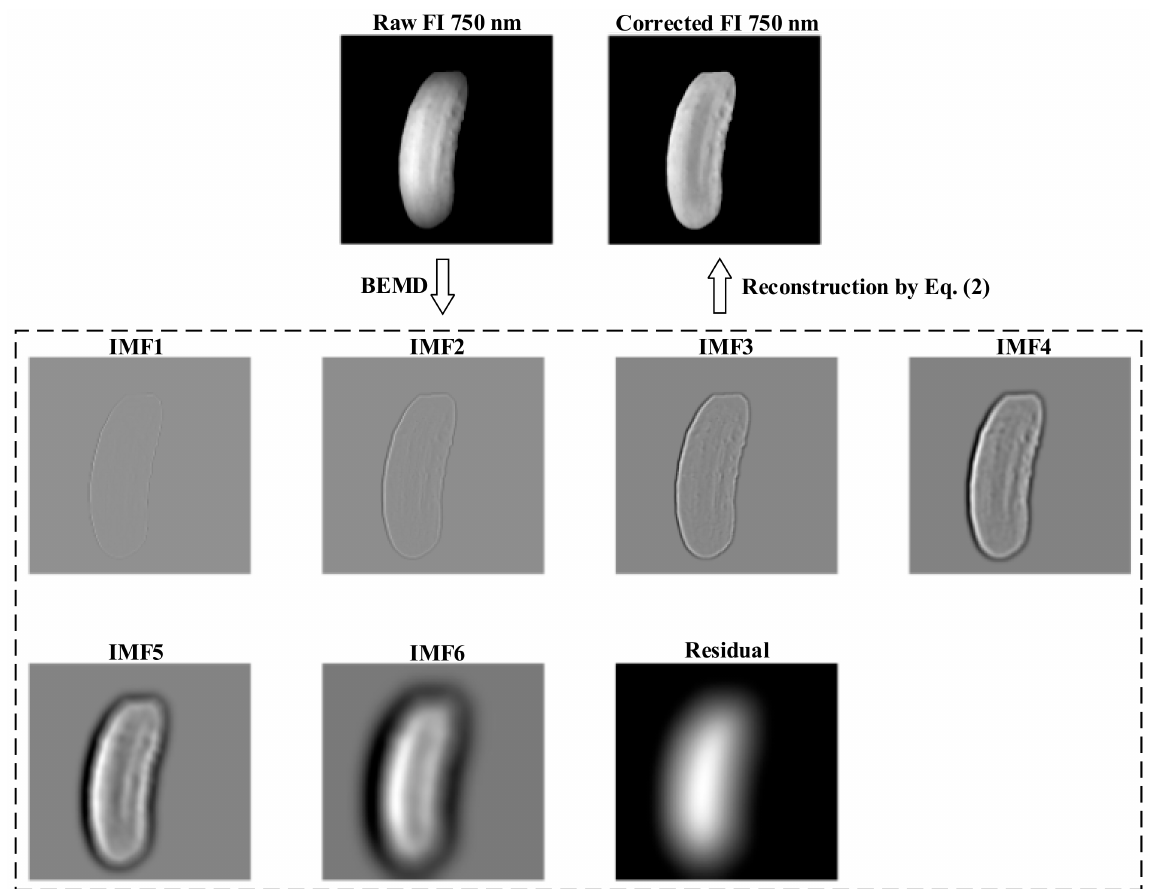
Figure 5. An example of bi-dimensional empirical mode decomposition (BEMD) of a raw fluorescence image (FI) at 750 nm into six intrinsic mode function (IMF) images, and vignetting correction of the FI image through image reconstruction defined by Equation